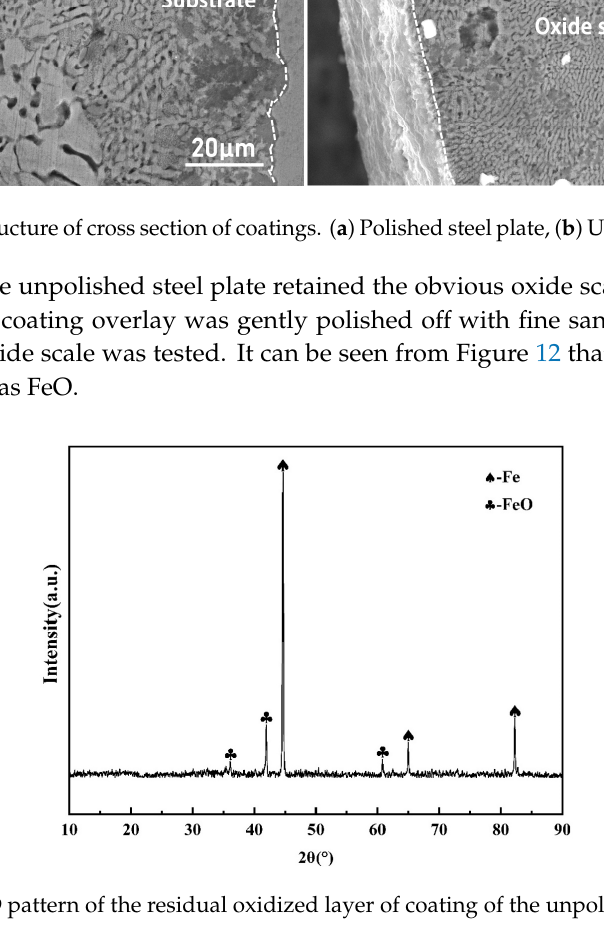
Figure 13. Element distribution of cross section of coating of polished steel plate. ( a ) The cross- sectional morphology of the coating, ( b ) All elements, ( c ) Al, ( d ) Fe, ( e ) Mg, ( f ) Zn. The schematic diagram of the coating formation of the polished steel plate was shown in Figure 14. Reduction efficiency was improved after the steel plate was polished, and the remaining oxide scale on the surface of the steel base was fully reduced to Fe. The hot-dip galvanizing process was the process of interdiffusion between bath atoms and steel matrix atoms, and the porous loose sponge Fe contributed to hot-dip galvanizing. It can be seen from Figure 2d that the scale remained on the steel substrate was sufficiently reduced to Fe. The diffusion of Fe atoms was promoted by the high temperature of the steel plate. The Fe atoms reacted with Al atoms in the immersion baths to form the Fe 4 Al 13 phase, which maintained a continuous structure in the overlay due to its toughness. At high temperature, the Fe 4 Al 13 phase separated into the surface of the overlay, resulting in serious strip-like protrusion defects on the surface of the coating. The separation of Fe 4 Al 13 in the coating was different from the periodic layered structure formed due to diffusion and migration [34–36]. The formation of this structure was mainly due to the high temperature before the steel plate entered the Zn-Al-Mg baths [37], and the amount of oxide scale on the steel plate significantly decreased after polishing, resulting in more Fe atoms spreading violently from the surface of the plate into the bath. The violent diffusion forms an Fe-Al alloy layer, and finally the alloy layer was separated from the matrix, causing serious protrusion defects on the surface of the coating.